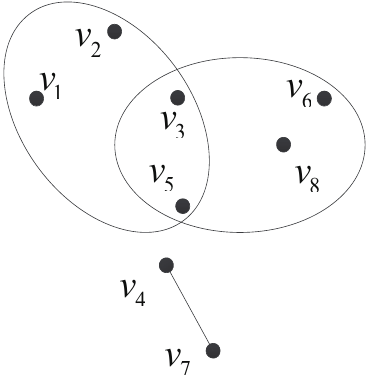
Figure 1. An example of